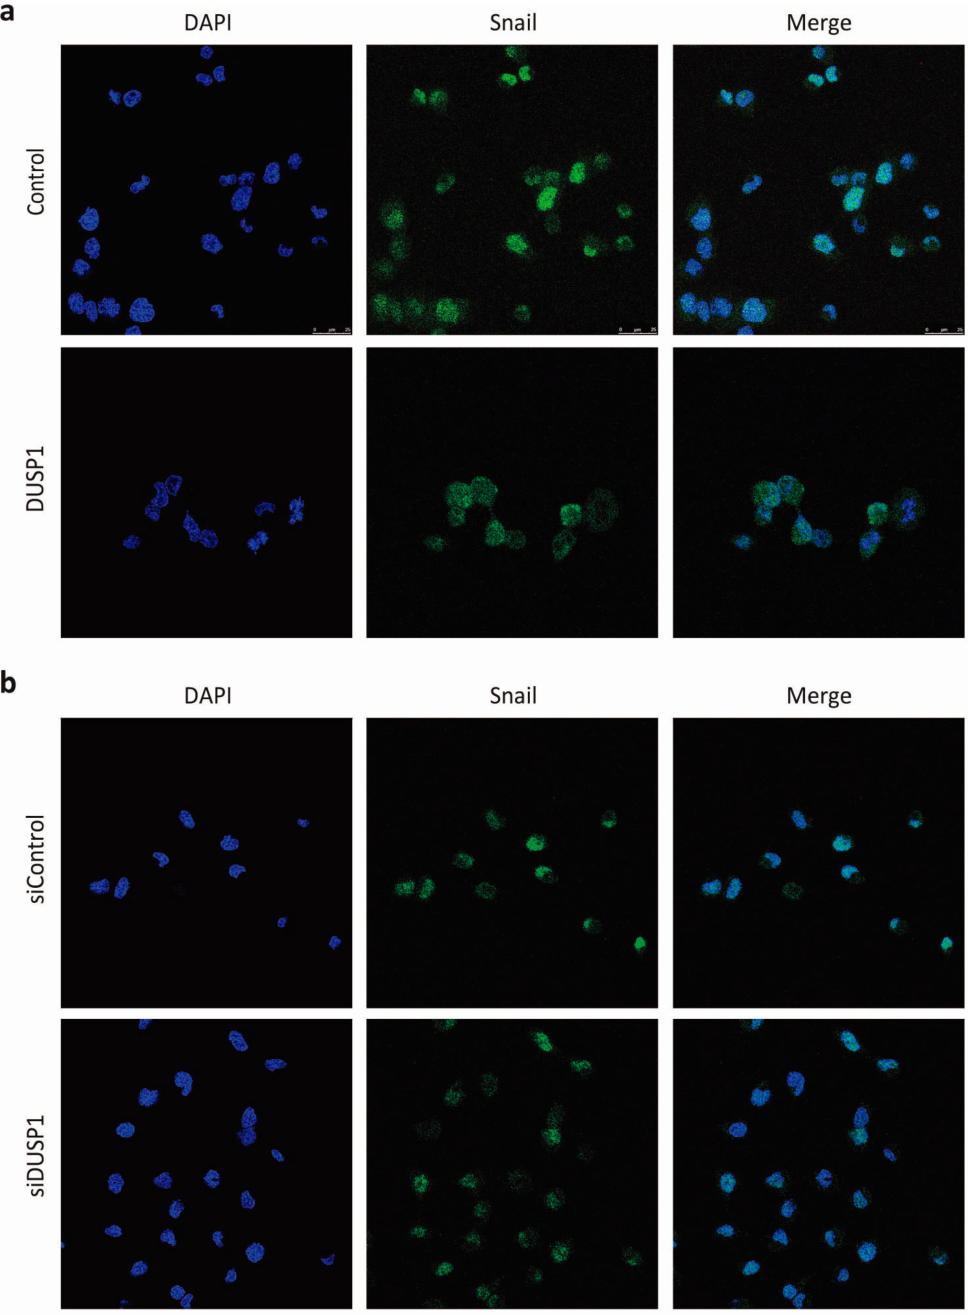
Figure 5. Snail subcellular location is regulated by the phosphatase DUSP1. ( a ) DU145 cells were transfected for 48 h with the Control or the DUSP1 vectors. ( b ) Cells were transfected for 48 h with the siControl or the siDUSP1. In both set of experiments, Snail subcellular location was determined by immunofluorescence as described in Material and methods. DAPI was used to identify the nuclei. Pictures are from one representative experiment of three with similar